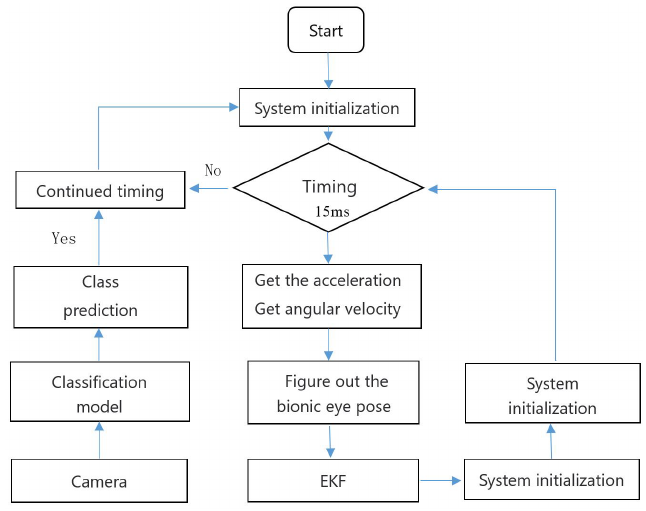
Figure 12. Software flow chart.